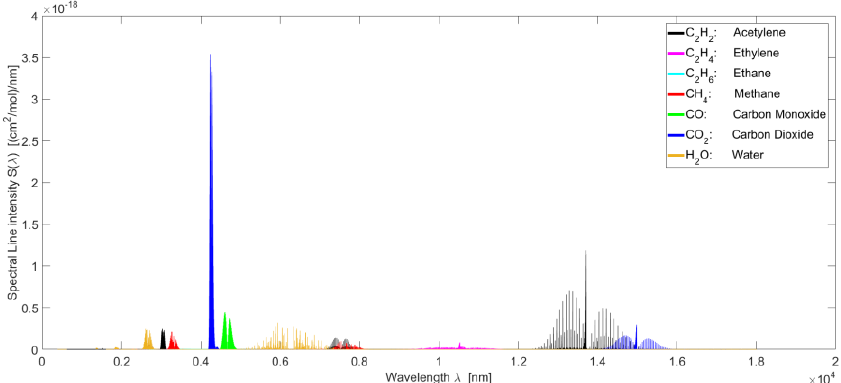
Figure 1. DGA key gas absorption coefficients as a function of wavelength [8].